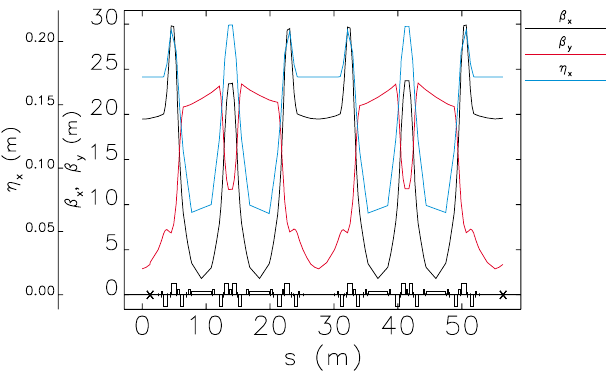
FIG. 2. (Color) Lattice functions corresponding to arrangement (b) from Fig. 1. The approximate locations of the cavities are marked with an ‘‘X’’.